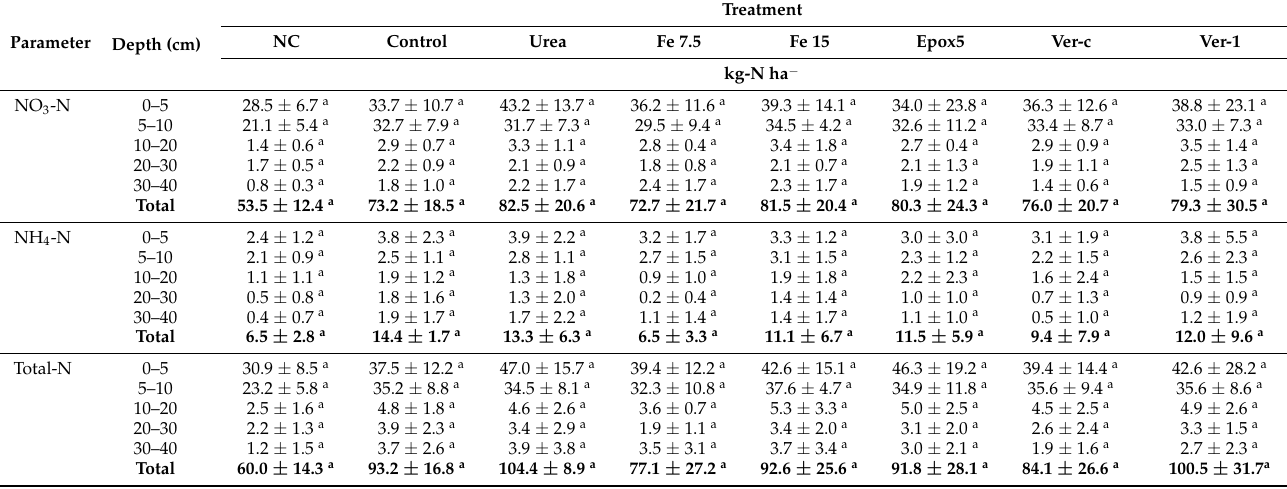
Table 1. The residual mineral nitrogen in the soil profile at different